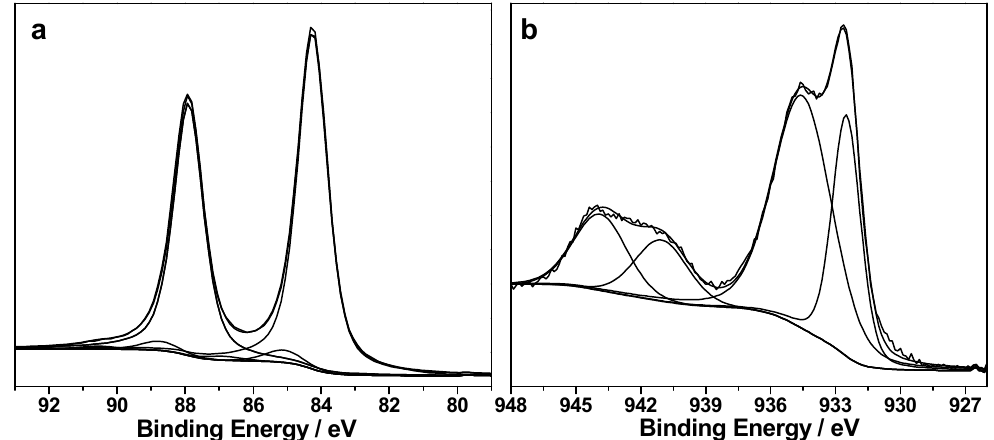
Figure 4. ( a ) Au4f XP region relevant to pristine AuNPs@SiNWs; ( b ) Cu2p 3/2 XP region relevant to pristine CuNPs@SiNWs.